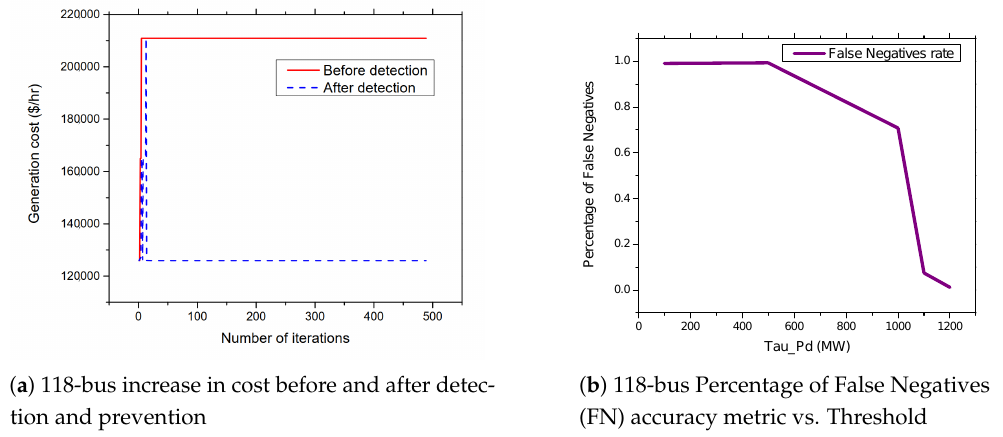
Figure 12. 118-bus systems increase in cost before and after detection and prevention and percentage of False Negatives (FN) accuracy metric vs.